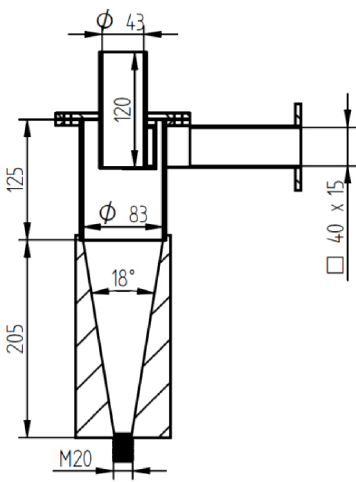
Fig. 6. Cyclone main dimensions (mm).